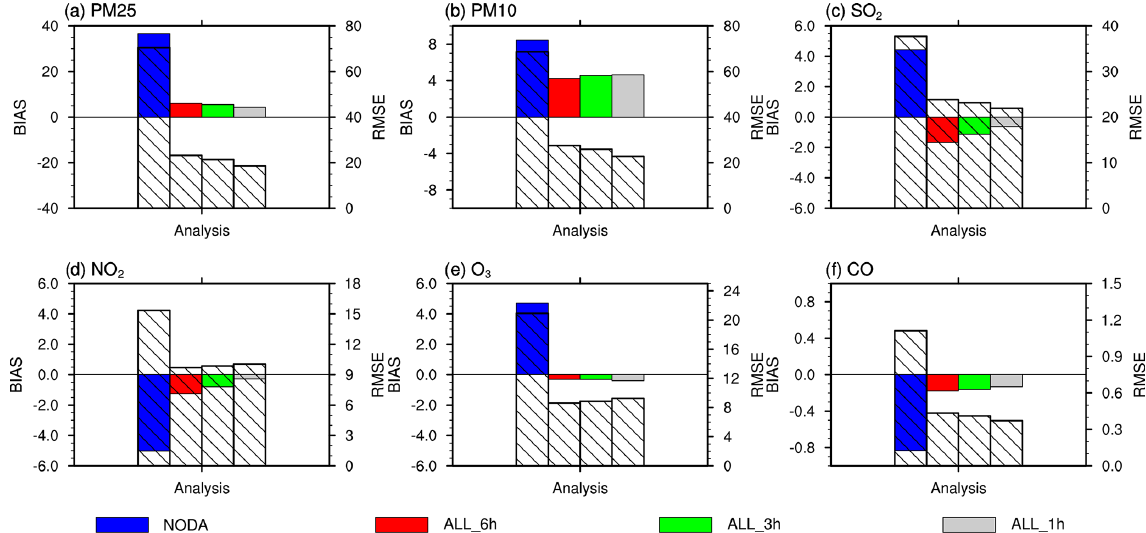
Figure 9. Same as Fig. 3, but for the experiments of NODA, ALL_6h, ALL-3h, and ALL_1h, respectively. Units of the y axis are micrograms per cubic meter in (a–e) and milligram per cubic meter in (f) .